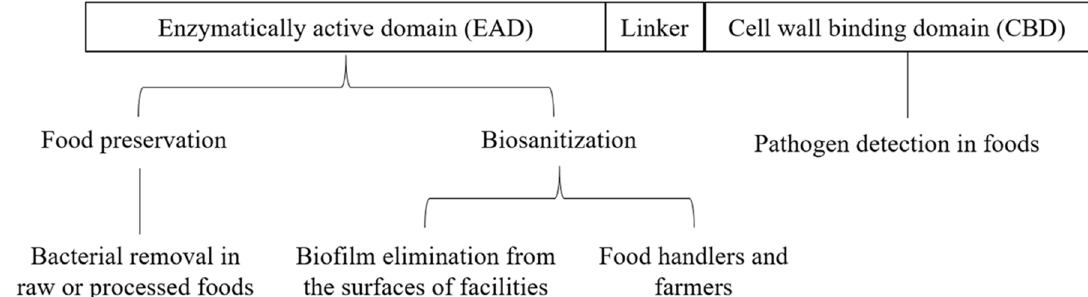
Figure 2. Applications of endolysins in food science fields for improving food safety. Enzymatically